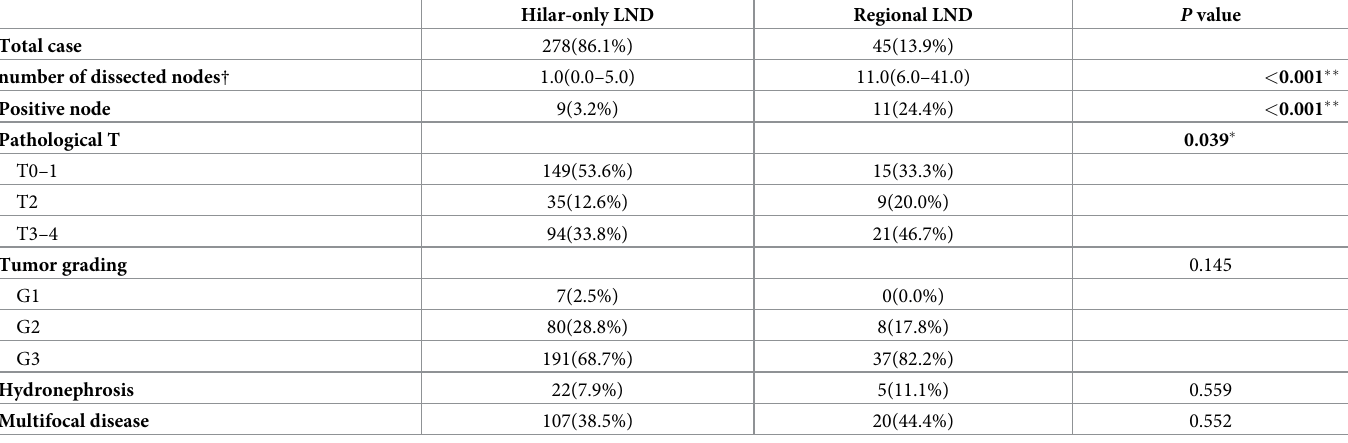
Table 3. Association between types of LND and clinic-pathological characteristics of cN0 UTUC patients treated with RNU and